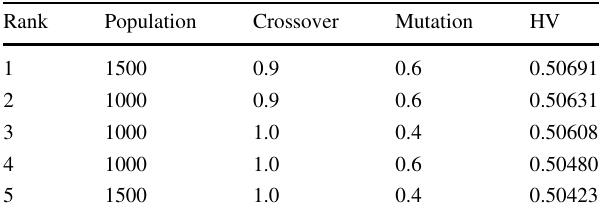
Table 4 NSGA-II: ranking of best 5 combinations based on HV mean values